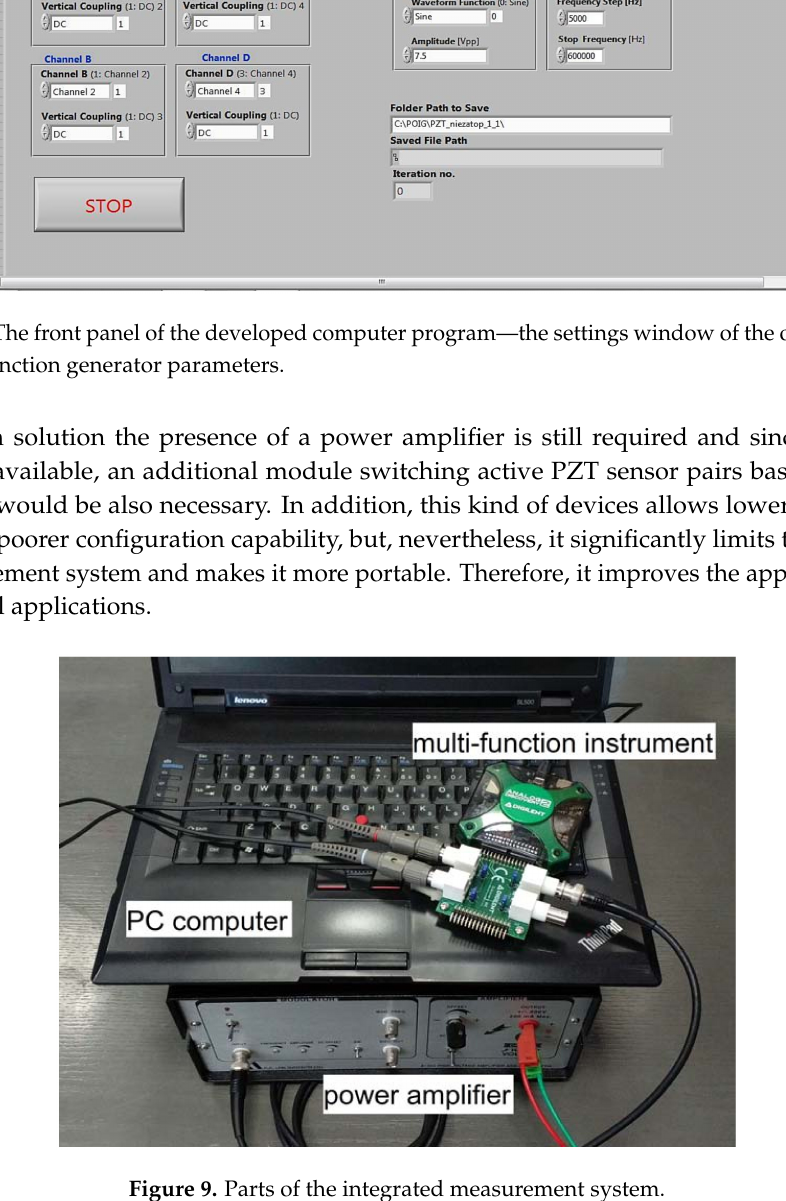
Figure 9. Parts of the integrated measurement